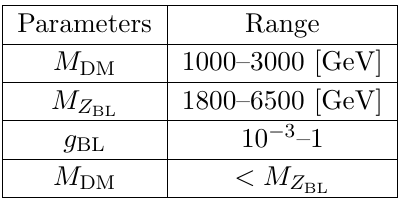
Table 3 . Parameters varied in generating the scatter plot near the Z BL resonance region.